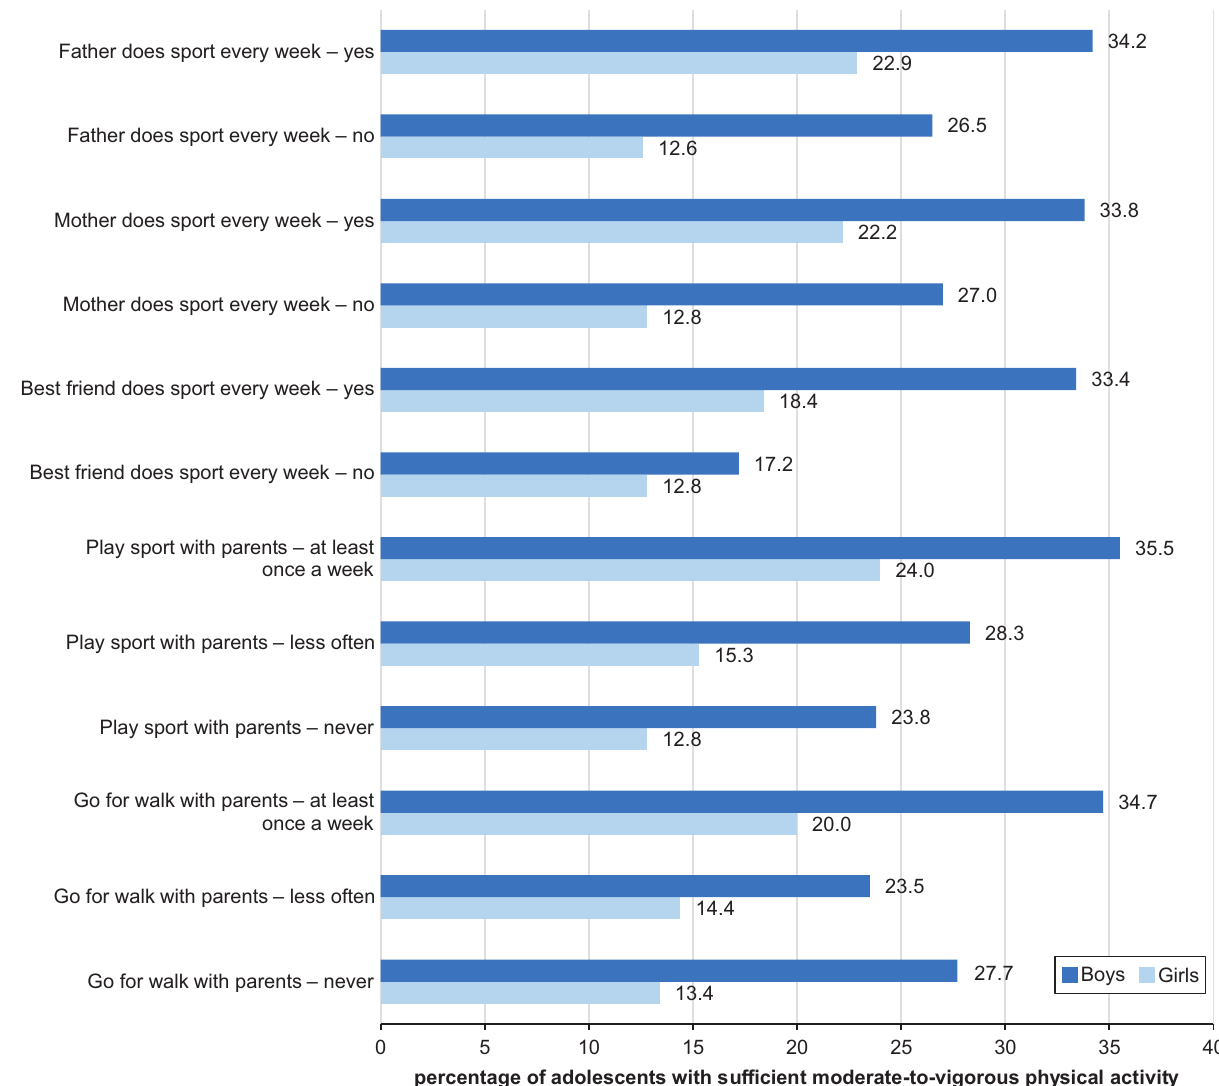
Figure 2. Relative frequency of selected variables in adolescents with sufficient moderate-to-vigorous physical